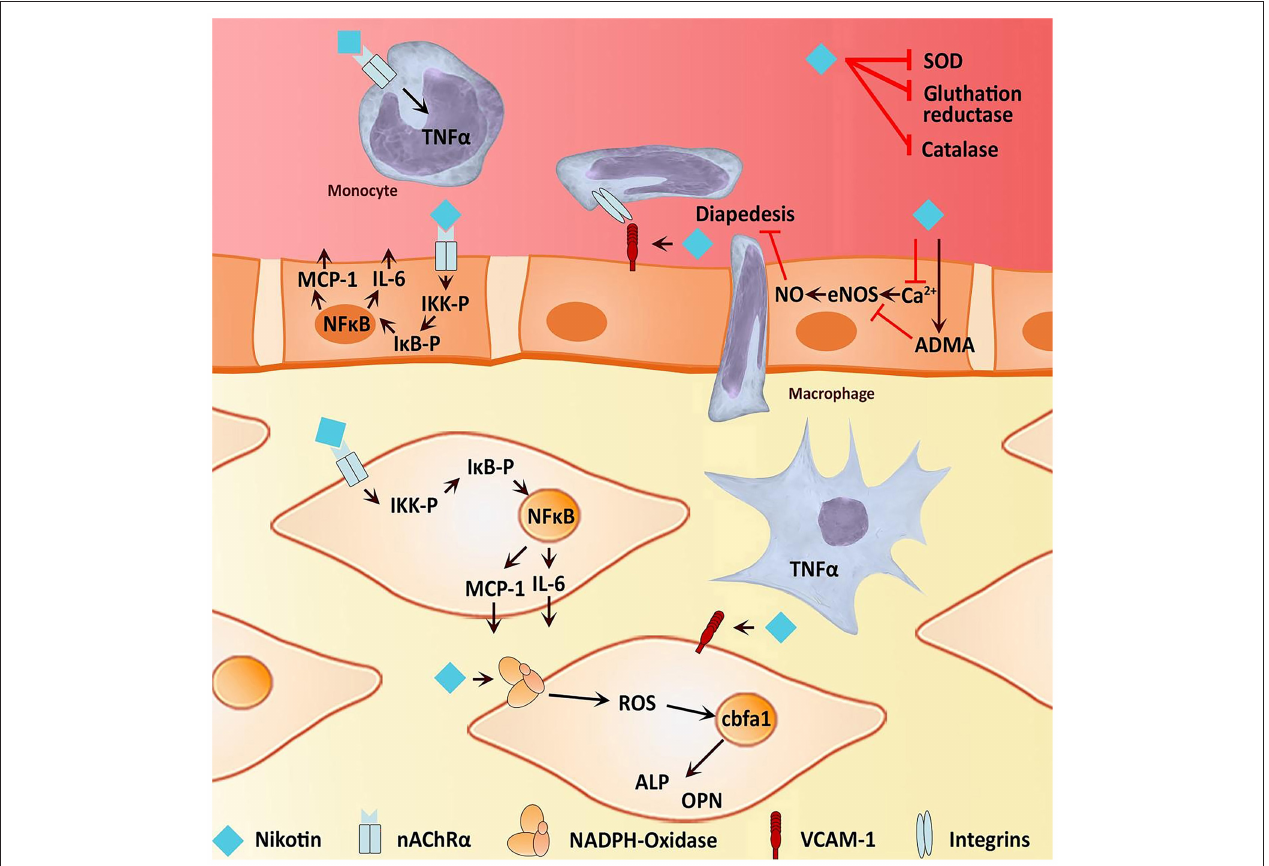
FIGURE 11 | Effects of nicotine on osteogenic transdifferentiation. Nicotine could induce an environment that promotes or even initiates vascular calcification of the media vessel wall by osteogenic transdifferentiation of VSMC. On the one hand, nicotine is capable of inducing inflammation by stimulating the activity of NF- κ B and therefore the expression of pro-inflammatory cytokines such as IL-6. Furthermore, there is evidence for nicotine to stimulate macrophages to express TNF- α , contributing to an inflammatory environment. On the other hand, nicotine increases oxidative stress, directly and indirectly, possibly leading to endothelial dysfunction Both endothelial dysfunction and an inflammatory environment facilitate an osteogenic phenotype of VSMC (45).